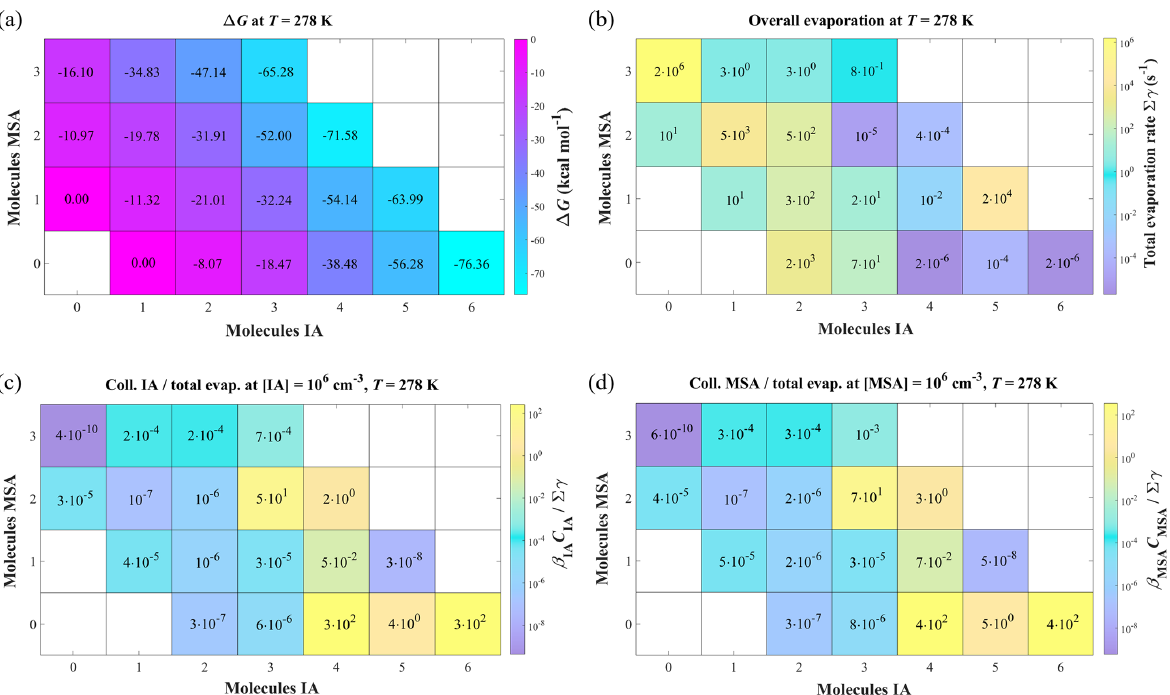
Figure 2. (a) Gibbs formation free energy ( (cid:49)G , kcalmol − 1 ) of the (IA) x · (MSA) y (0 ≤ x ≤ 6, 0 ≤ y ≤ 3, 1 < x + y ≤ 6) clusters calculated at the RI-CC2/aug-cc-pV( T + d )Z(-PP)// ω B97X-D/6-311 ++ G(3df,3pd) + aug-cc-pVTZ-PP level of theory; T = 278K, and p = 1atm. (b) The total evaporation rate coefficients ( (cid:80) γ , s − 1 ) and the ratios of collision frequencies with (c) IA monomer or (d) MSA monomer versus total evaporation rate coefficients ( β IA C IA / (cid:80) γ or β MSA C MSA / (cid:80) γ ) of the corresponding clusters. β is the rate coeffi- cient of cluster collision with monomer, and C is the monomer concentration.